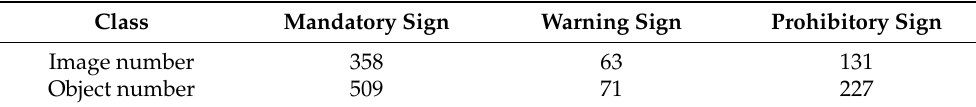
Table 1. The number of oblique aerial images and objects of each road sign category.